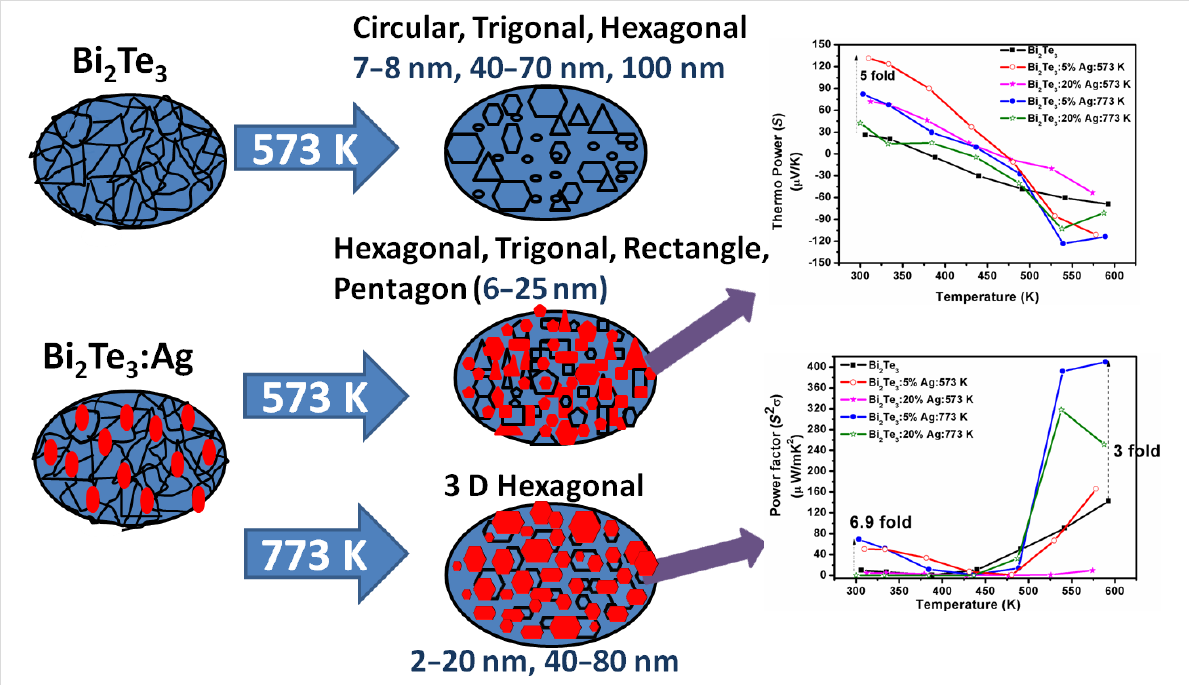
Figure 8: Schematic of effect of Ag nanoparticles in Bi 2 Te 3 leads to the enhancement in thermoelectric properties.